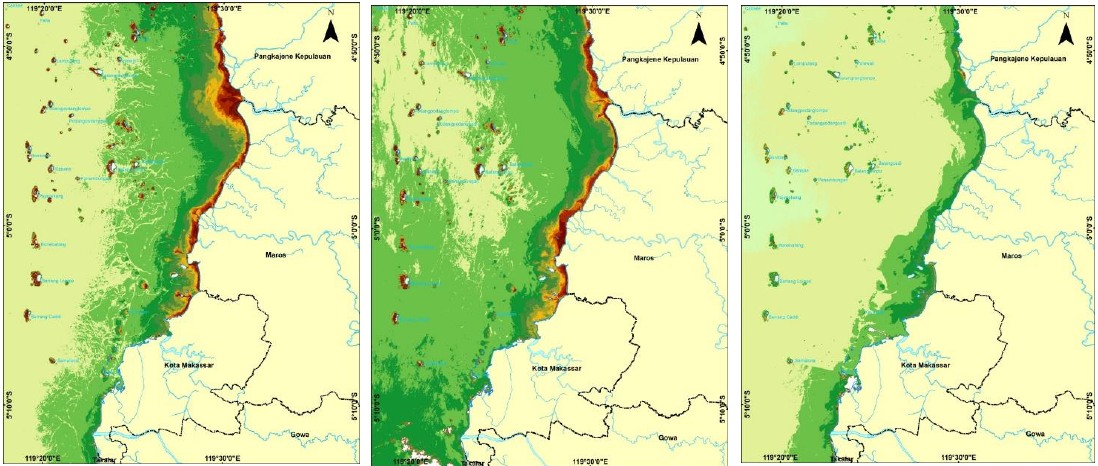
Figure 8. TSS Distribution around Bontosua and Ballang Caddi island and near from the main land and shore lines Spermonde waters in the east season, (a) 2013, (b) 2016, (c) 2018-2019.